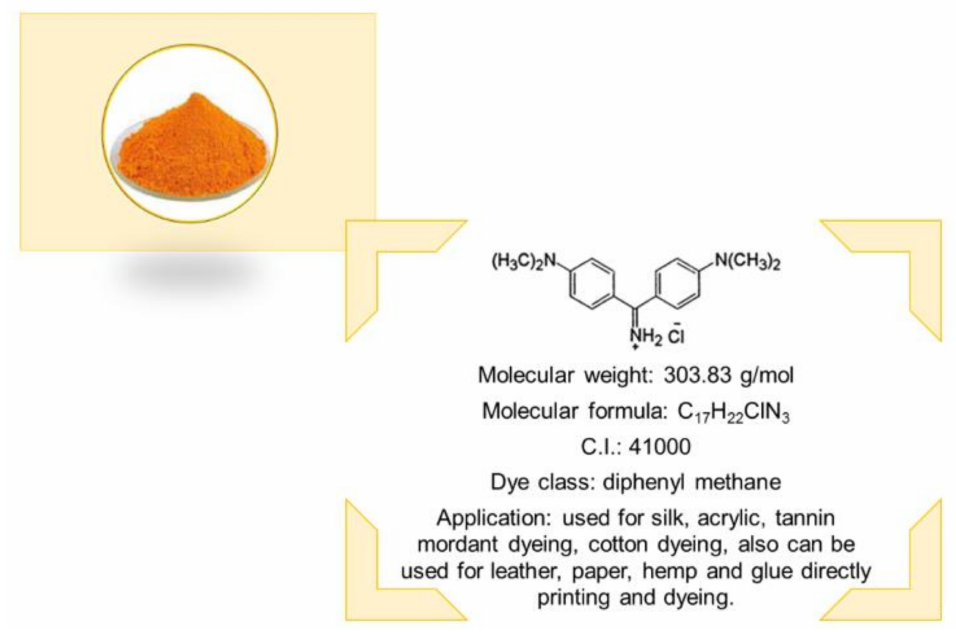
Figure 1. Properties of auramine O.